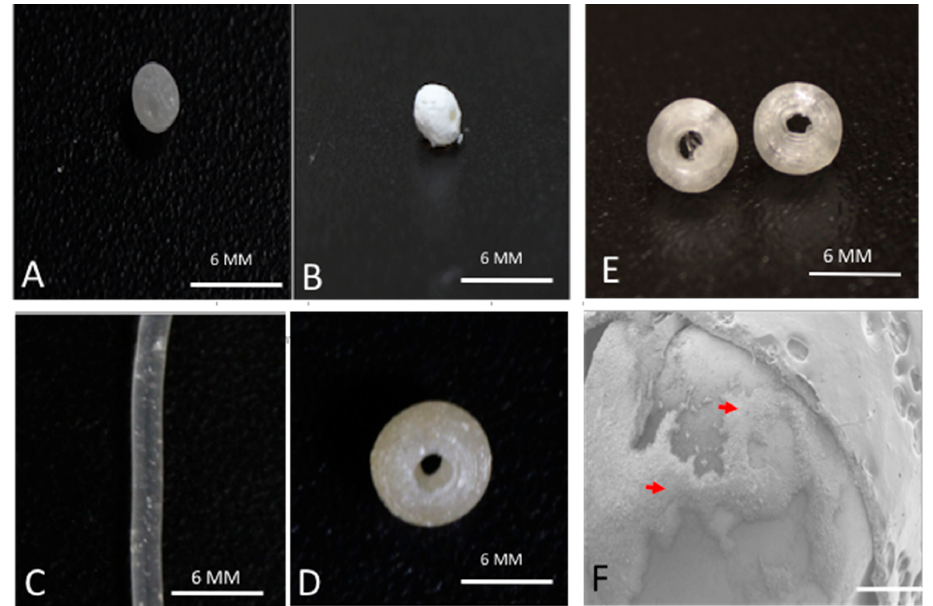
Figure 1. Coated pellets, filaments and beads. ( A ) 1.5 wt % gentamicin (GS) loaded halloysite nanotubes (HNTs), coated on polylactic acid (PLA) pellet; ( B ) 10 wt % gentamicin loaded HNTs, coated on PLA pellet; ( C ) 7.5 wt % GS-HNT 3D printed PLA filament; ( D ) 7.5 wt % GS-HNT 3D printed PLA bead; ( E ) 3D printed PLA control bead; ( F ) SEM of GS-HNT coated pellet, red arrows indicate GS coating, bar = 5 mm.